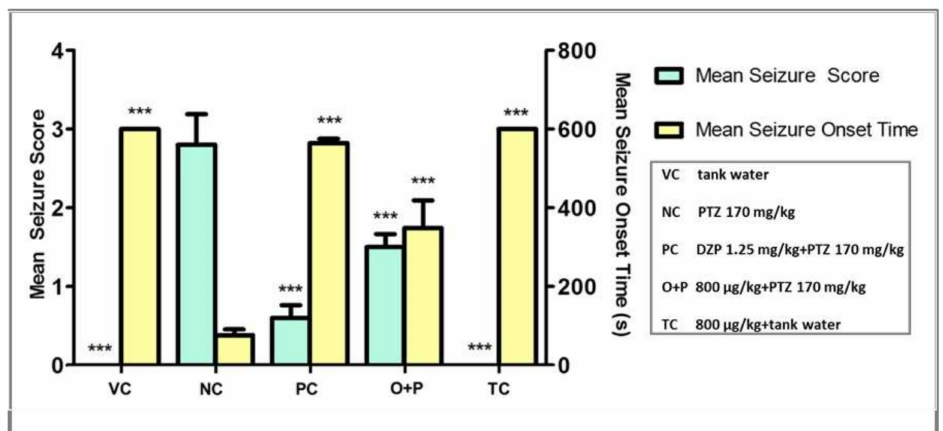
Figure 5. Mean seizure scores and mean seizure onset time (s) for the corresponding 5 experimental groups. Data are mean ± SEM. Experiments were repeated in n = 10, *** showed p < 0.001 against negative control. One-way ANOVA with Dunnett’s post-hoc test. VC (tank water, i.p.), NC (PTZ 170 mg / kg, i.p.), PC (DZP 1.25 mg / kg + PTZ 170 mg / kg, i.p.), O + P (OSLP 800 µ g / kg + PTZ 170 mg / kg, i.p.) and TC (OSLP 800 µ g / kg + tank water, i.p.).